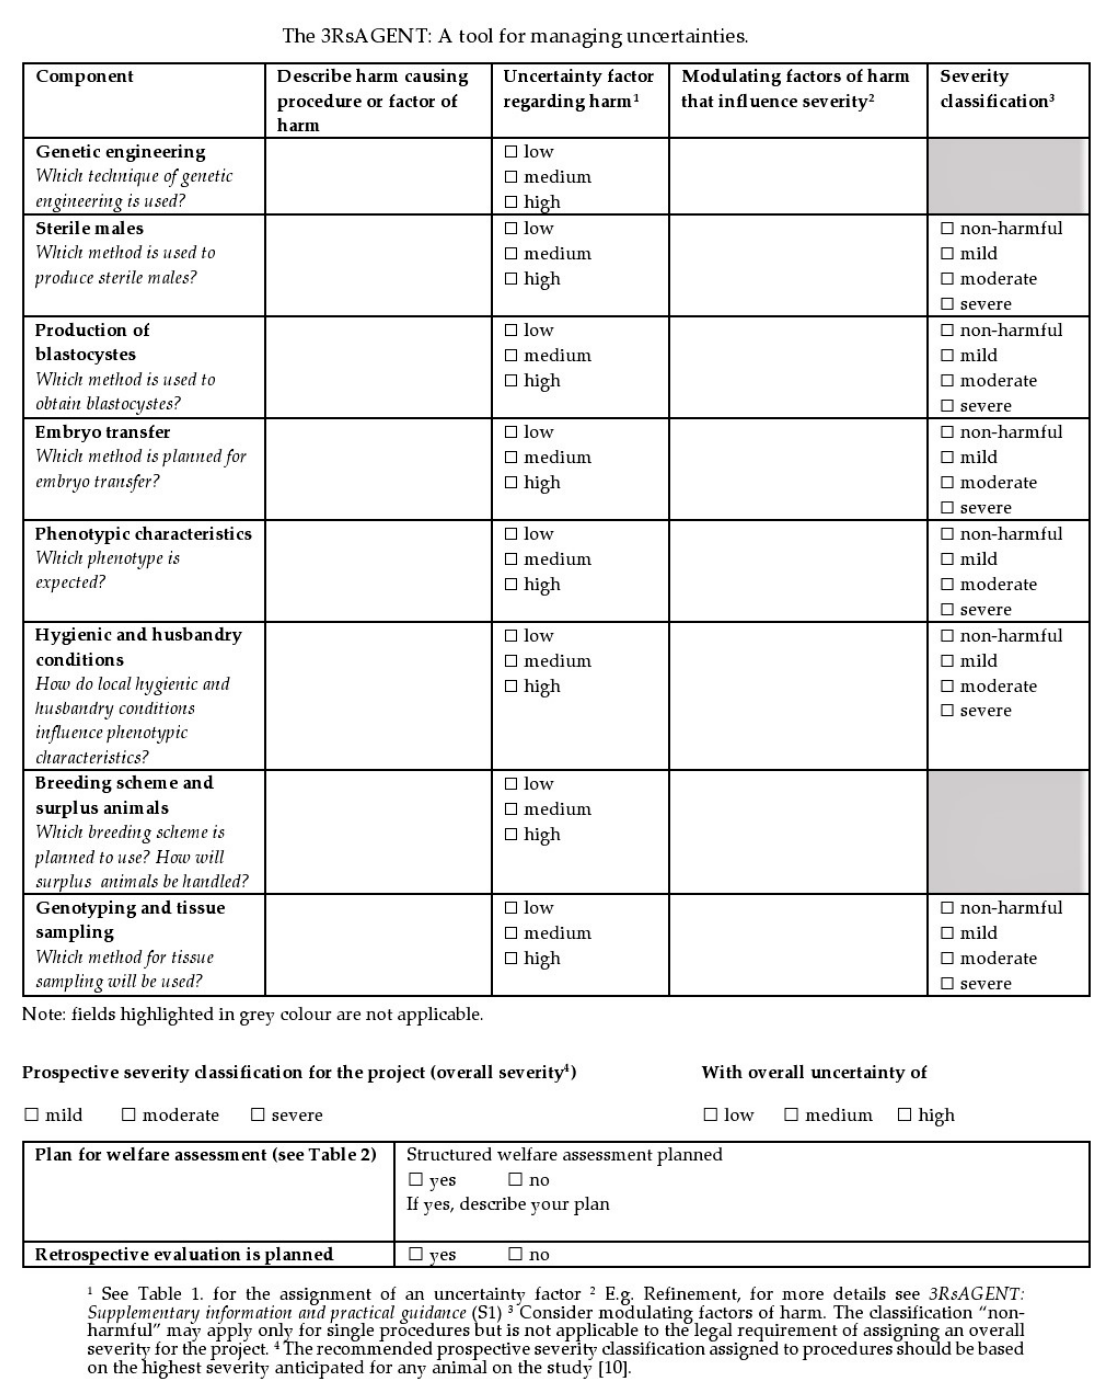
Figure 2. The 3RsAGENT: A tool for managing uncertainties.